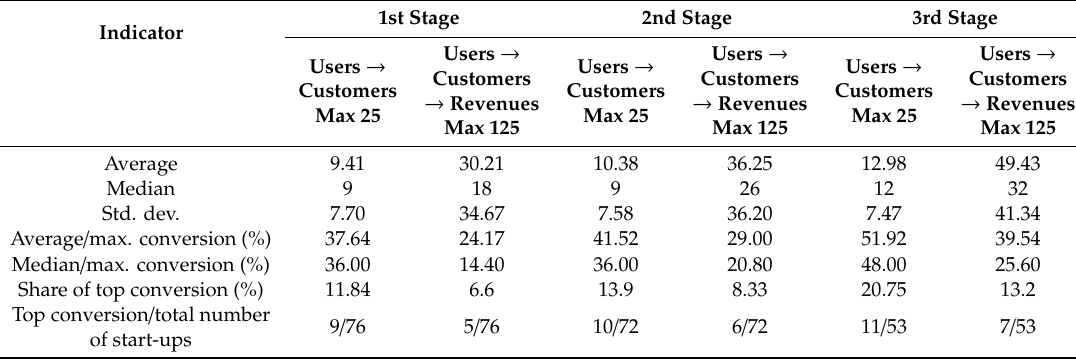
Table 4. Conversion of start-up performance in three stages of